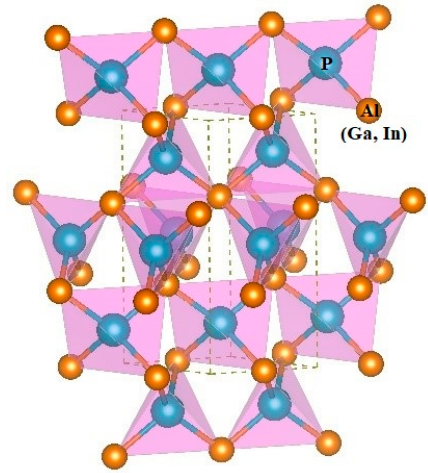
Figure 2. The 3D crystal structure of P 6 4 22- X P ( X = Al, Ga, or In).